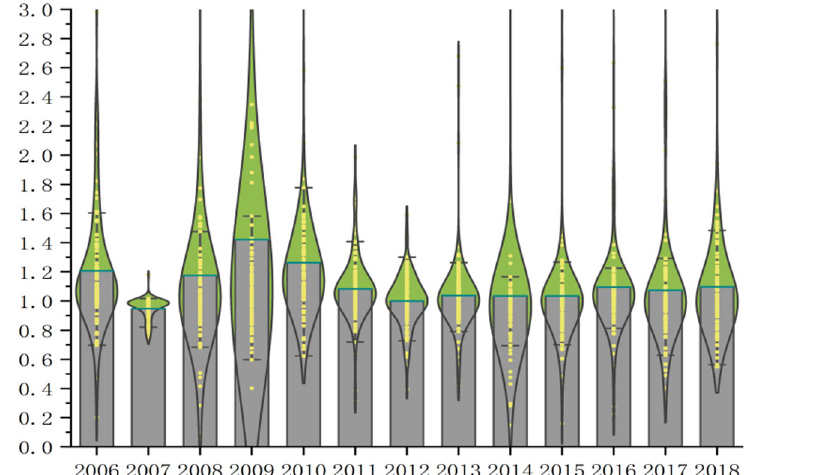
Fig 2. Green total factor productivity of industry in the Yangtze River Economic Zone, 2006–2018.